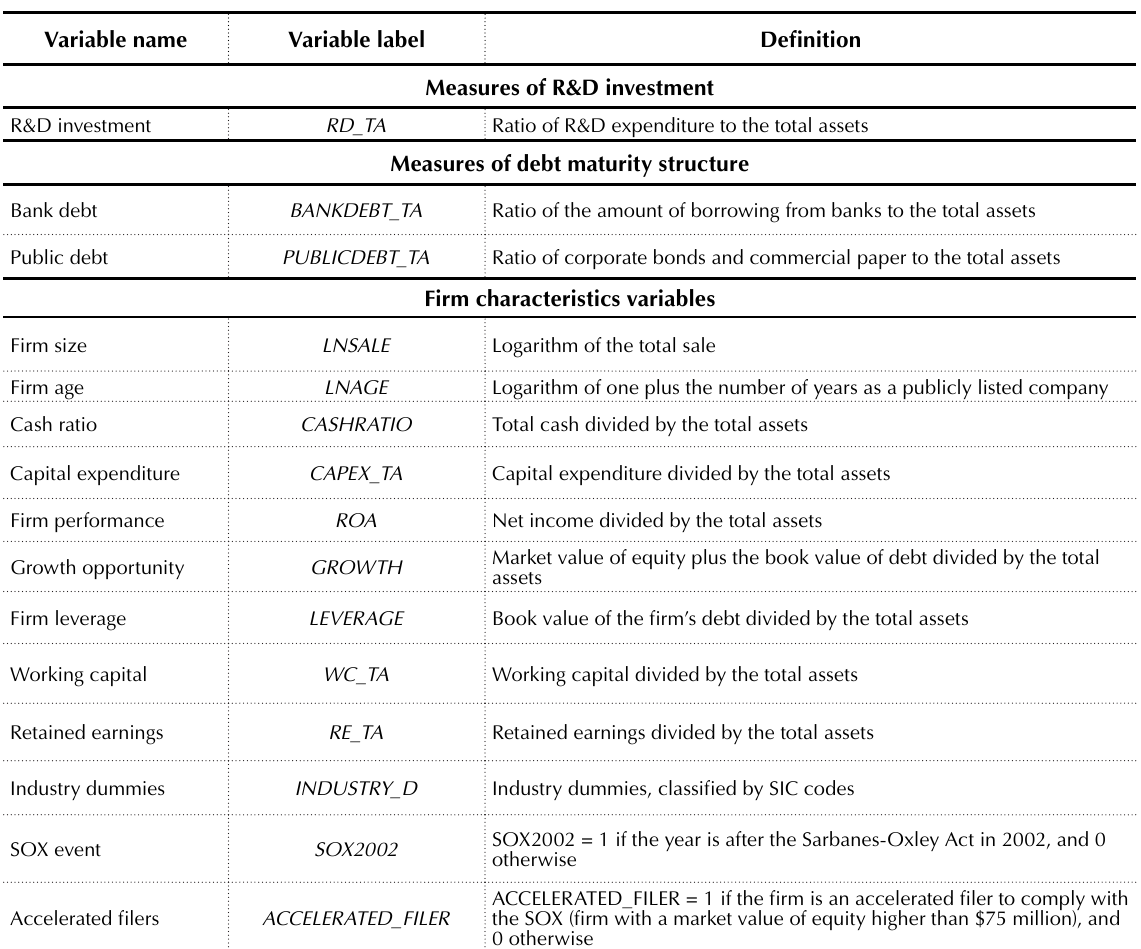
Table 1a. Definition of